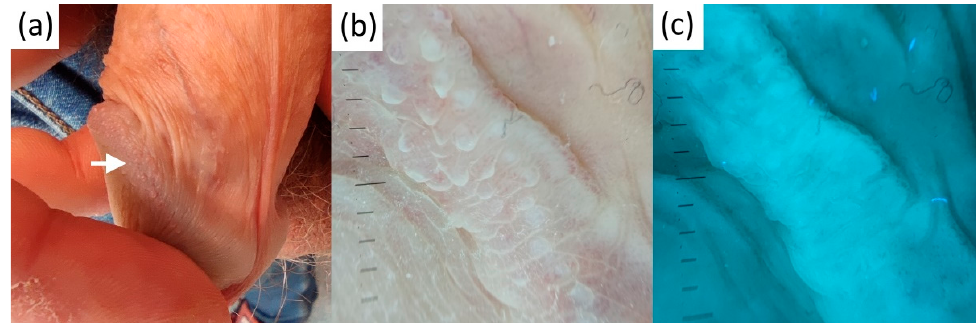
Figure 6. Clinical ( a ), contact-polarized ( b ), and ultraviolet-induced fluorescence ( c ) dermatoscopic images of penile pearly papules. Polarized dermatoscopy of a single non-pigmented lesion of genital porokeratosis showed a specific dermatoscopic clue, namely the annular keratotic rim (cornoid lamella), which in our case was perifollicular and non-interrupted, whereas the affected area was